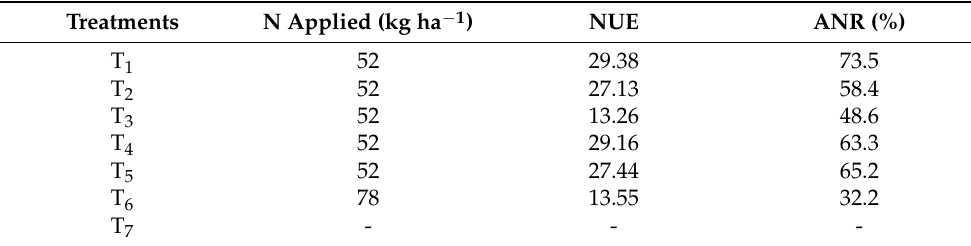
Table 4. Effects of different methods of deep placement of urea fertilizer on apparent N recovery (ANR) and N use efficiency (NUE) of BRRI